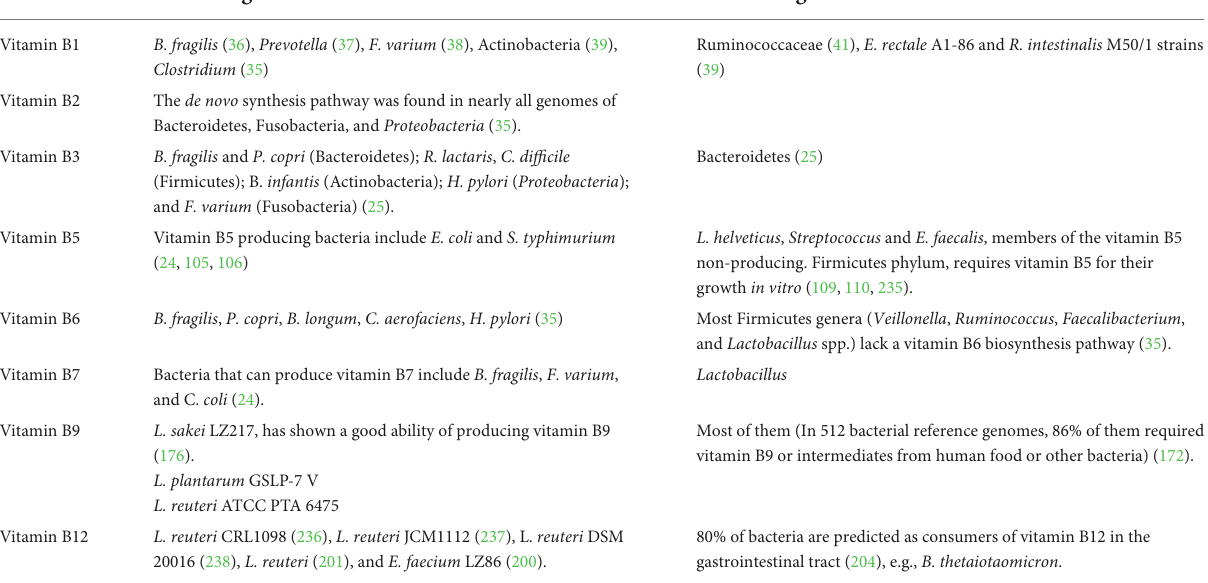
TABLE 2 Summary of vitamin B-producers and vitamin B-consumers. Vitamin Producing